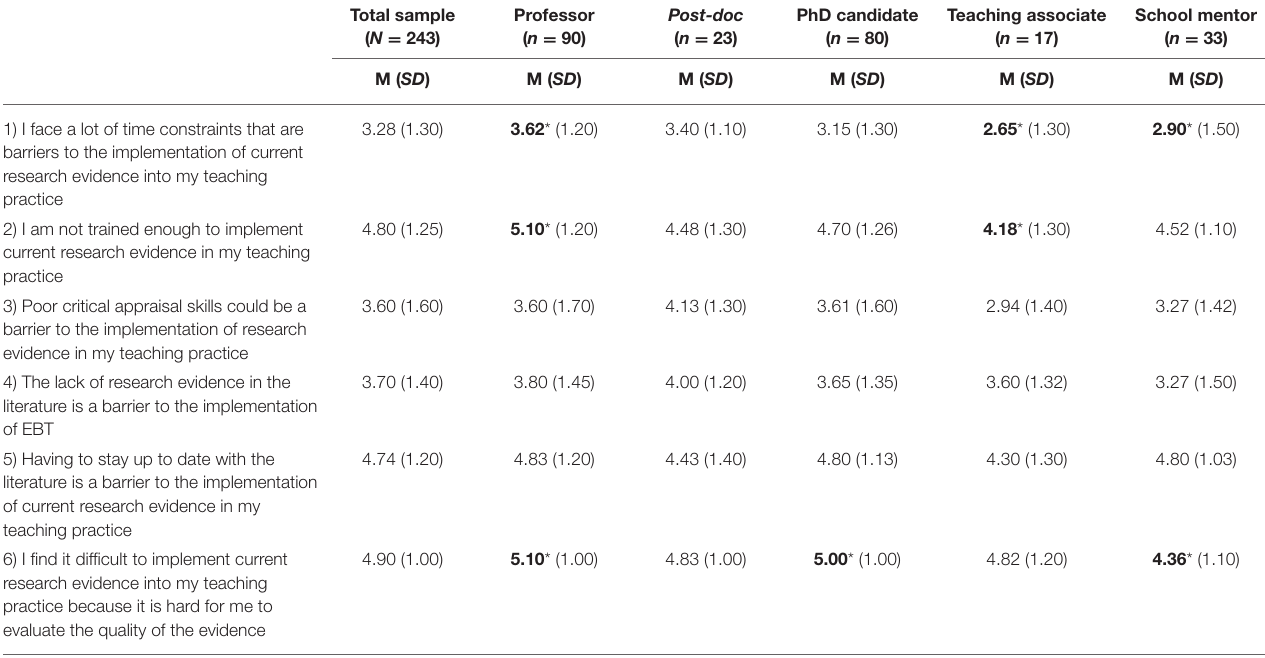
TABLE 4 | Teacher educators’ perceived challenges to